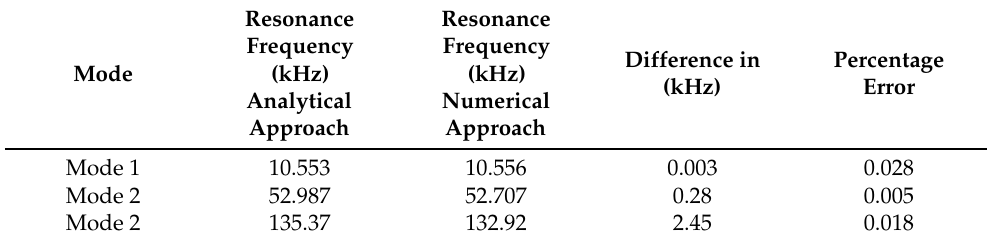
Table 2. Comparison of resonance frequencies of the first three cantilever transverse vibration modes.